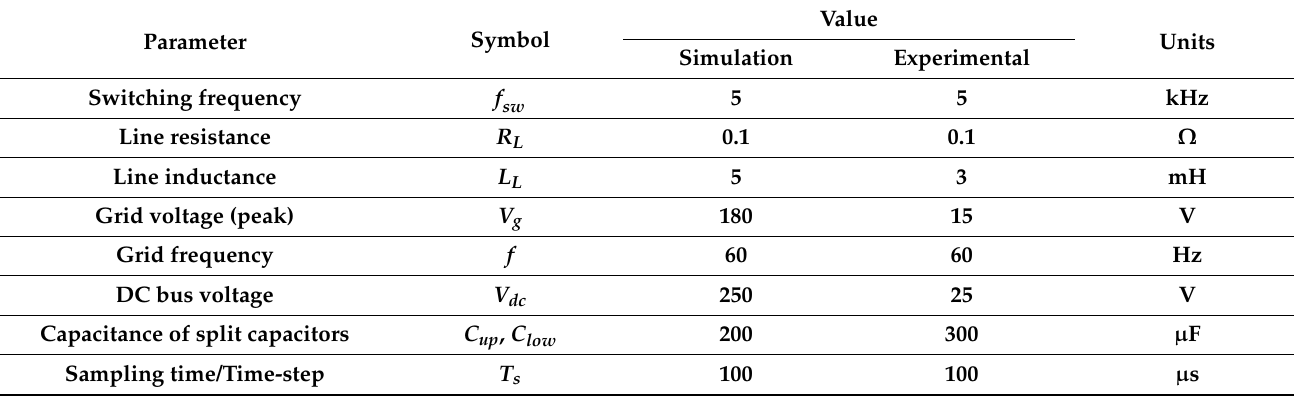
Table 3. Parameters of simulation and experimental grid-tied